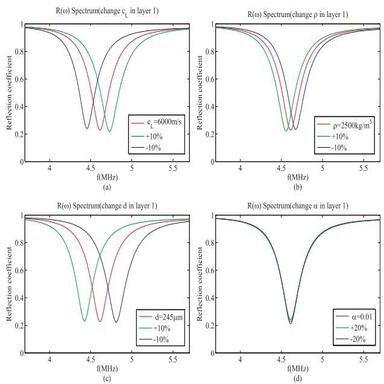
The theoretical reflection spectrum of the aluminum-TC4 bi-layered structure with the changeable properties in layer 1 including the (a) longitudinal wave velocity (b) density (c) thickness and (d) attenuation.